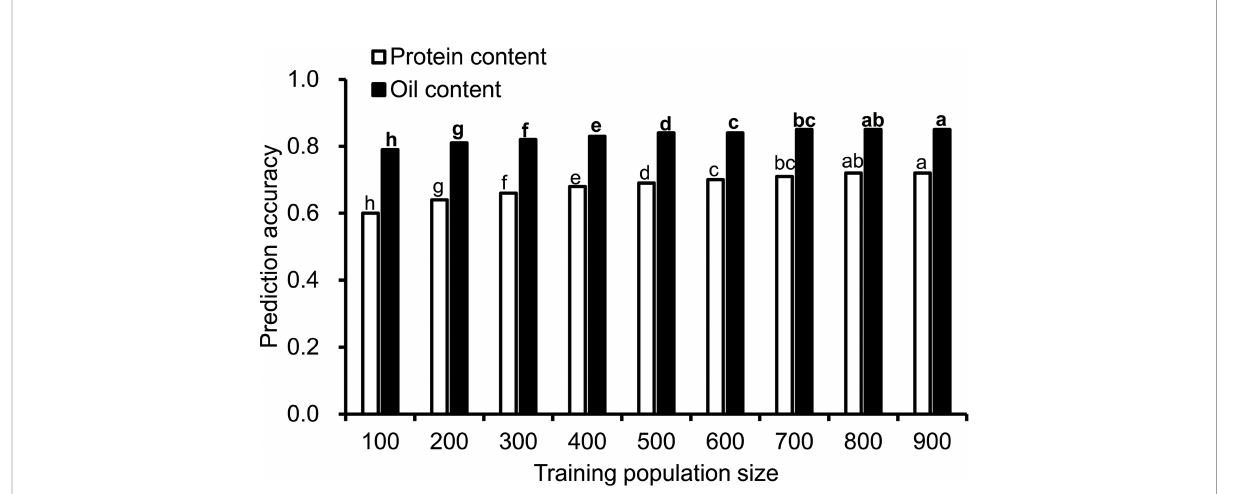
FIGURE 1 The in fl uence of training population size on prediction accuracy. Cross-validated prediction accuracies of ridge regression best linear unbiased prediction (RR-BLUP) for protein and oil content among 1,007 soybean germplasms grown at Urbana, IL in 2001 and 2002. "a – h" indicates the difference between different columns. The difference between columns marked with different letters was signi fi cant (P<0.05), and there was no signi fi cant difference between columns marked with the same